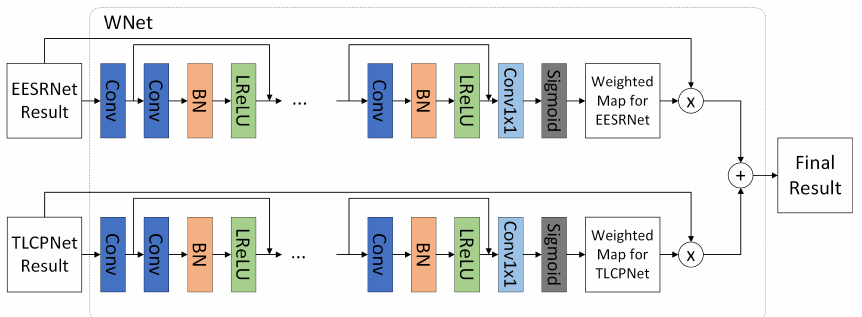
Figure 8. Architecture of the